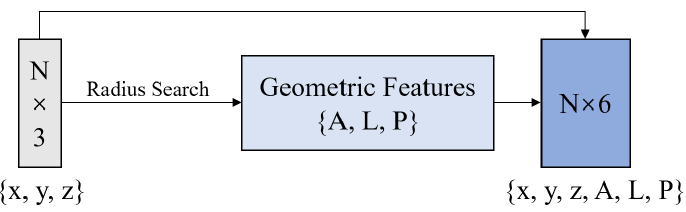
Figure 6. Network structure of the GFE